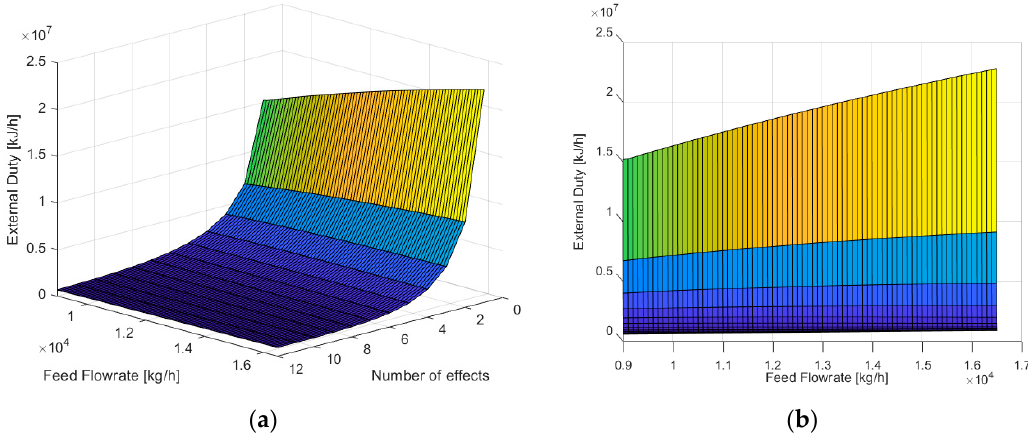
Figure 4. External duty under uncertain operating conditions: ( a ) side view; ( b ) front view.